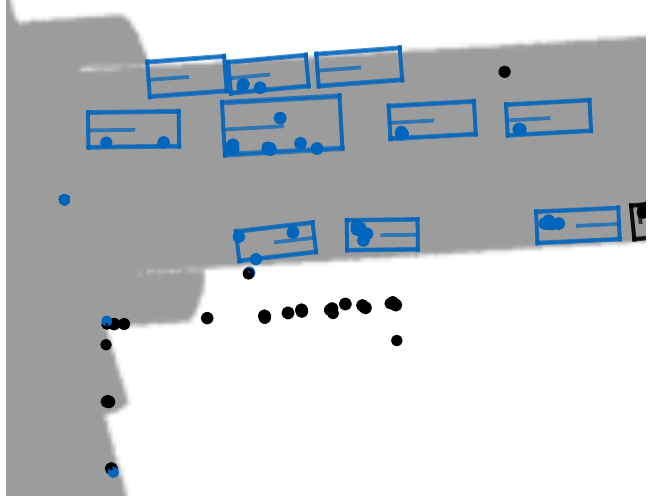
Figure 10. Even in the overfitting scenario, misclassifications are present when static objects are segmented. NuScenes sample token: